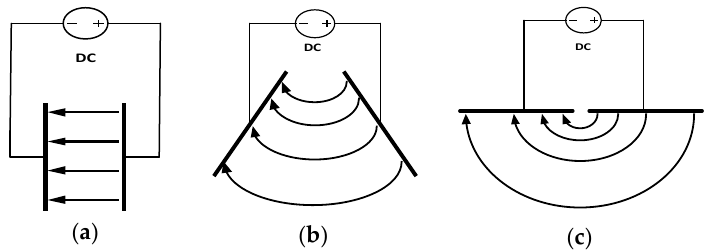
Figure 1. Electric field distribution as two conventional parallel electrodes ( a ) changing from angled electrodes ( b ) into two co-planar electrodes ( c ).